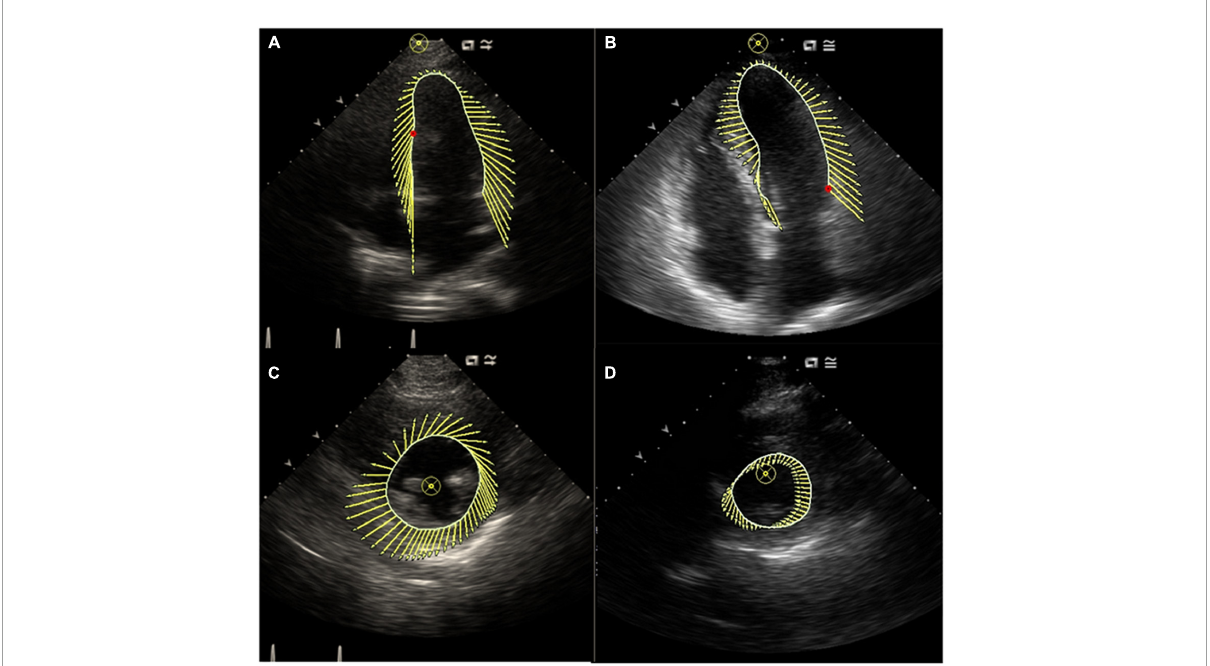
FIGURE1 (A) Characterization of LV motion in the long axis in a control subject; (B) characterization of LV motion in the long axis in a patient with AF; (C) characterization of LV motion in the short axis in a control subject; (D) characterization of LV motion in the short axis in a patient with AF. This figure showed synchronous motion of LV segments in control subject and impaired synchronous motion of LV segments in a patient with AF.